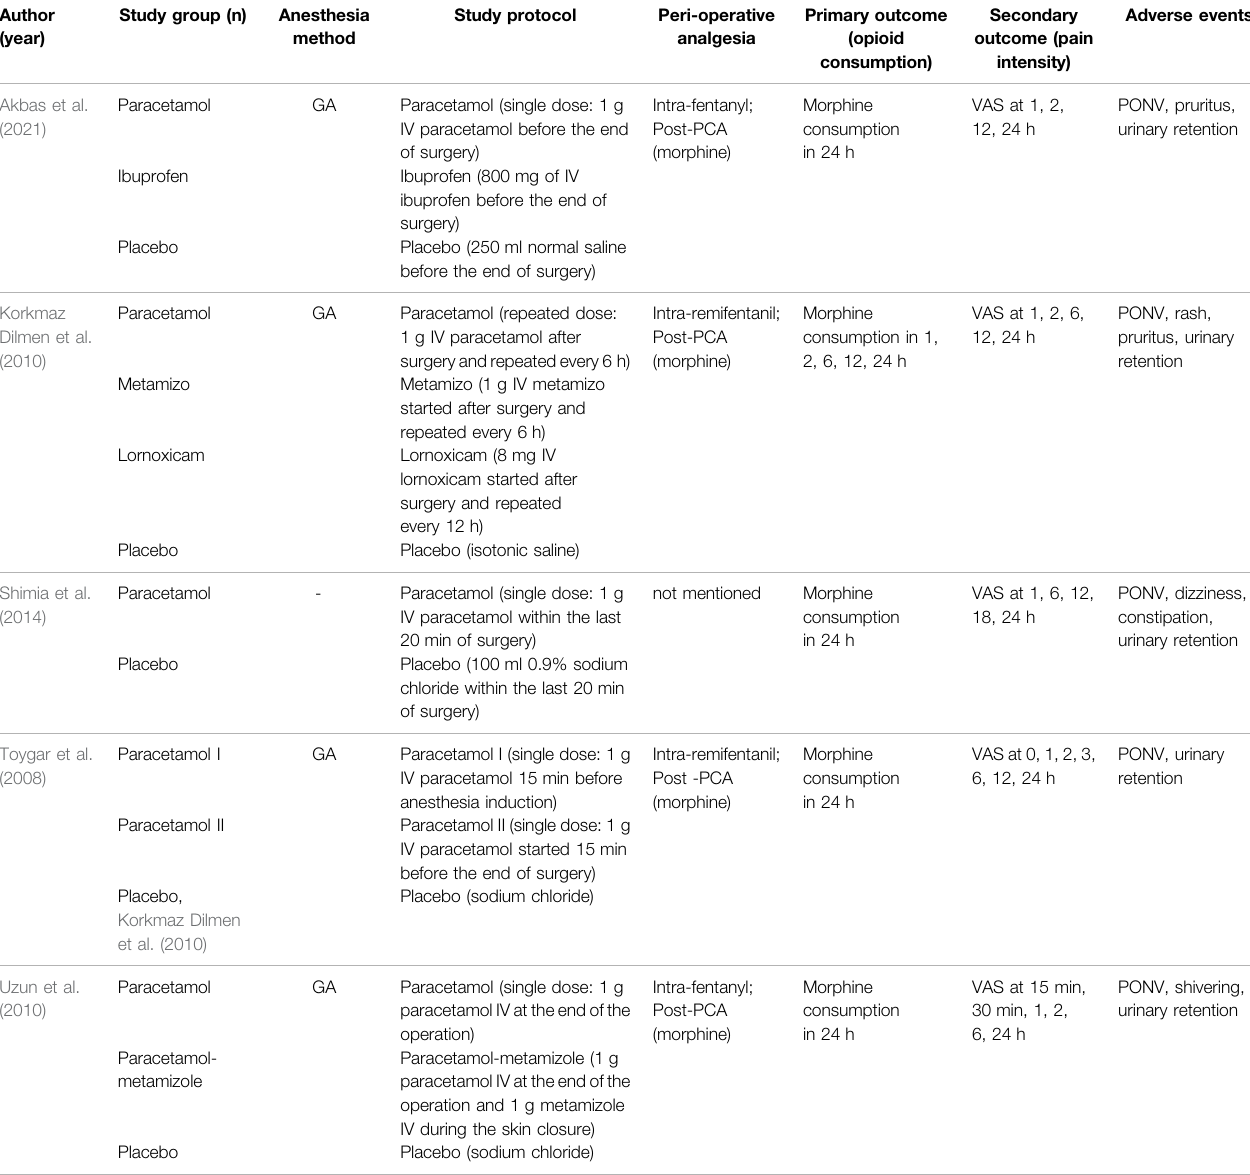
TABLE 1 | Overview of analyzed